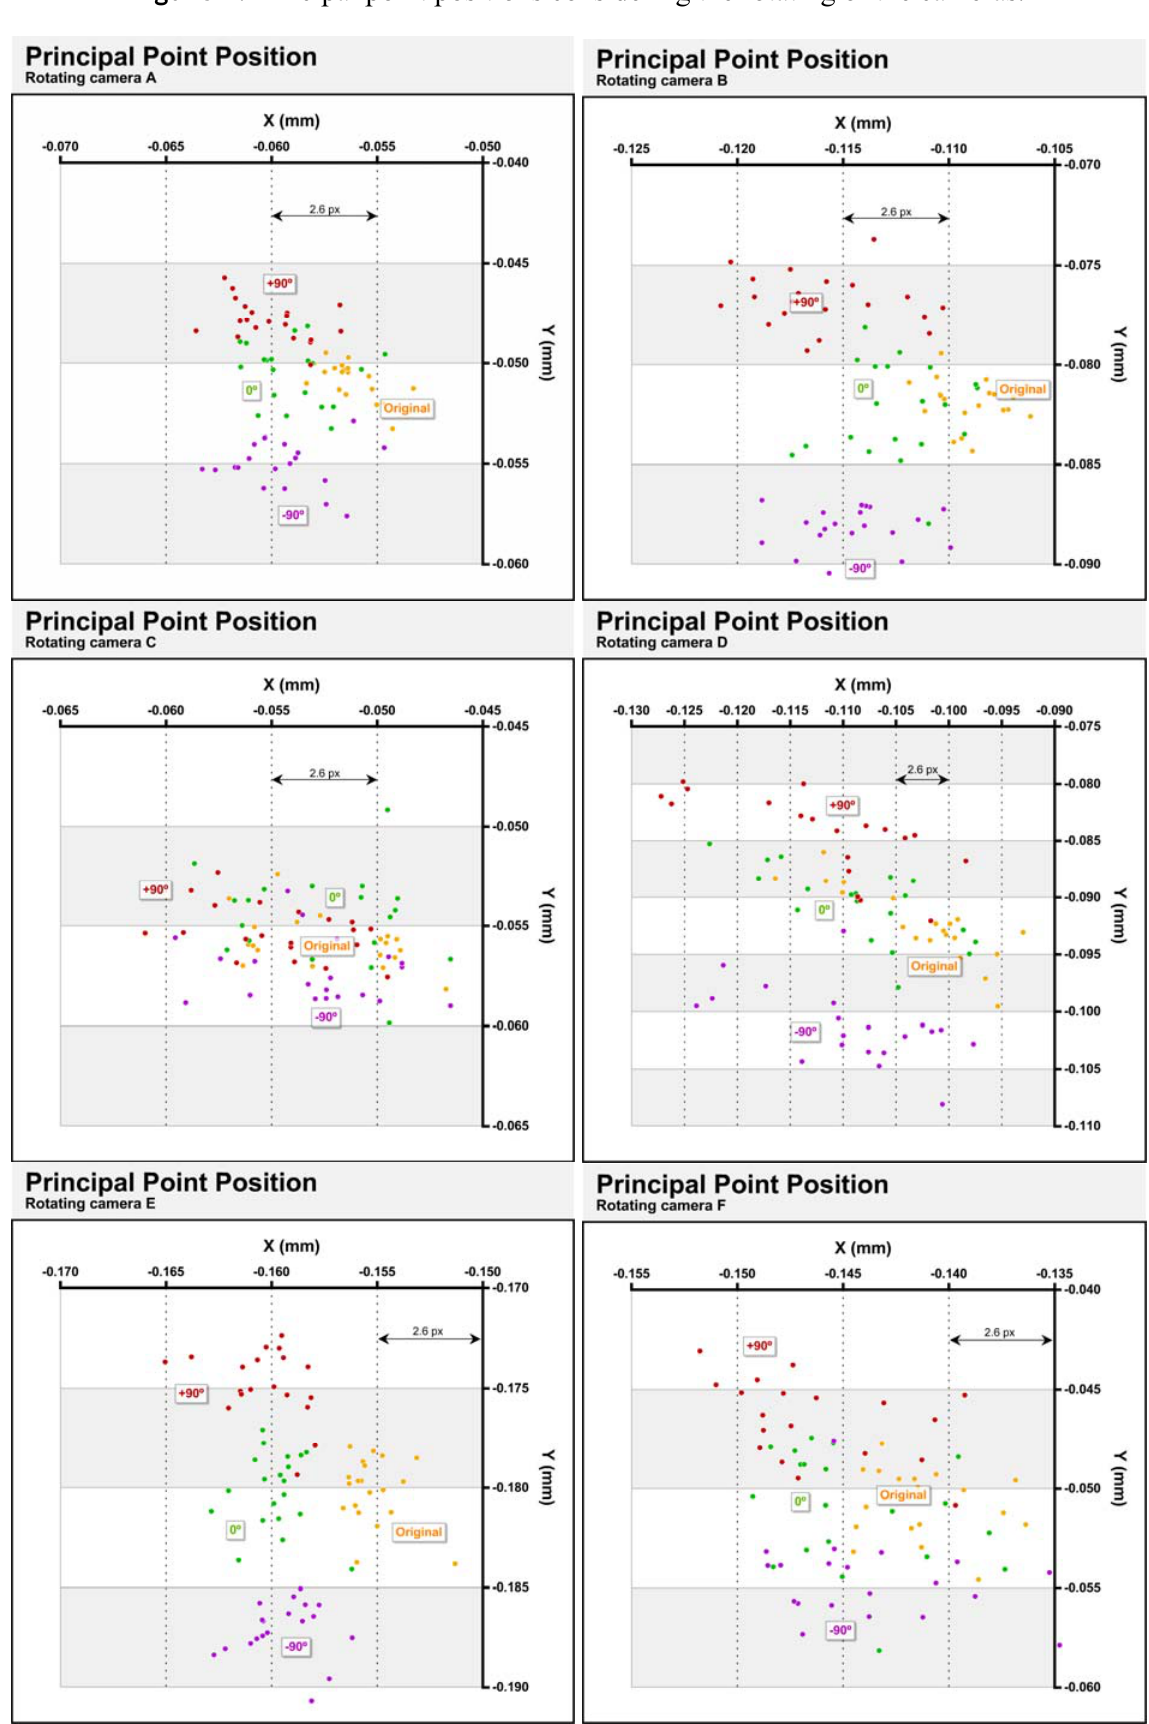
Figure 7. Principal point positions considering the rotating of the